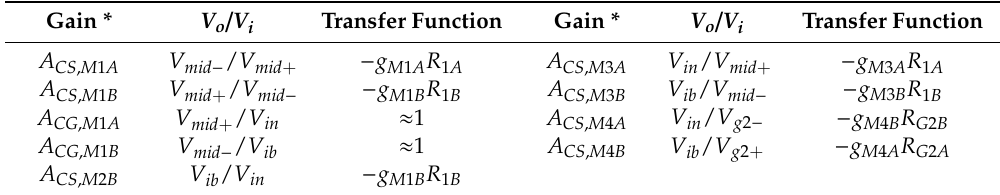
Table 1. Table of gain functions at DC in DVGTIA input